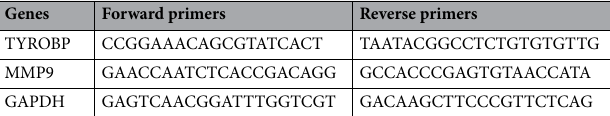
Table 2. PCR primer sequences of